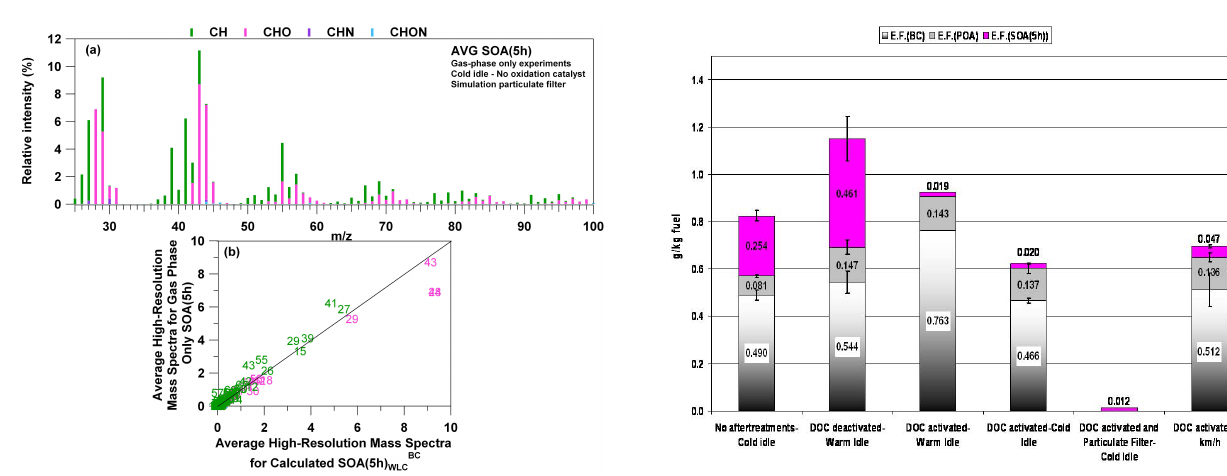
Fig. 11. (a) Average high-resolution mass spectrum of SOA after 5h of aging from the diesel gas-phase only experiments (SOA(5h), experiments #18 and 19 in Table 1) with the Transporter. (b) Scat- ter plot between the mass spectrum of SOA(5h) versus the average SOA mass spectrum for the Transporter estimated with Eq. (7) for experiments #13 and 17 in Table 1.